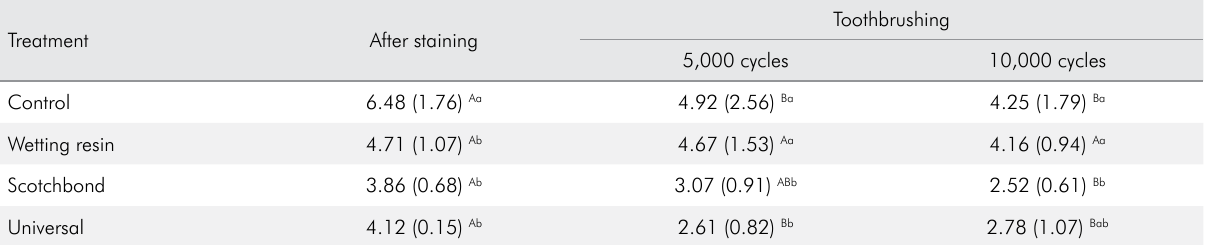
Table 3. Mean and standard deviation (SD) of